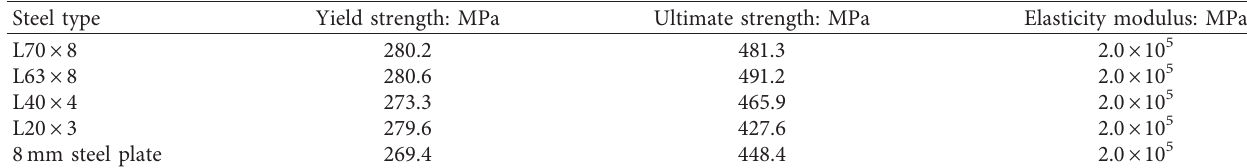
Table 4: Mechanical properties of steel.